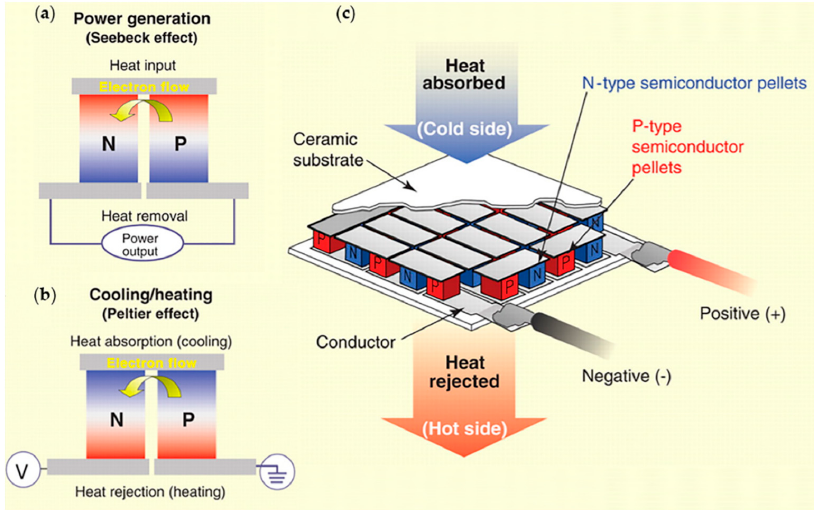
Figure 1. Illustration of TE effect and represented devices. ( a ) Schematic of the Seebeck effect. Electric current is produced when P-type and N-type semiconductors are placed under temperature differences at the same time. ( b ) Schematic of the Peltier effect. Heating or cooling is generated when electric current flows through P-type and N-type semiconductors. ( c ) Schematic of a TE generator. To improve the system-level conversion efficiency, P-type and N-type semiconductor pellets are connected in parallel under ceramic substrates, forming TE devices. Reproduced with permission from [2]. Copyright 2008, American Association for the Advancement of